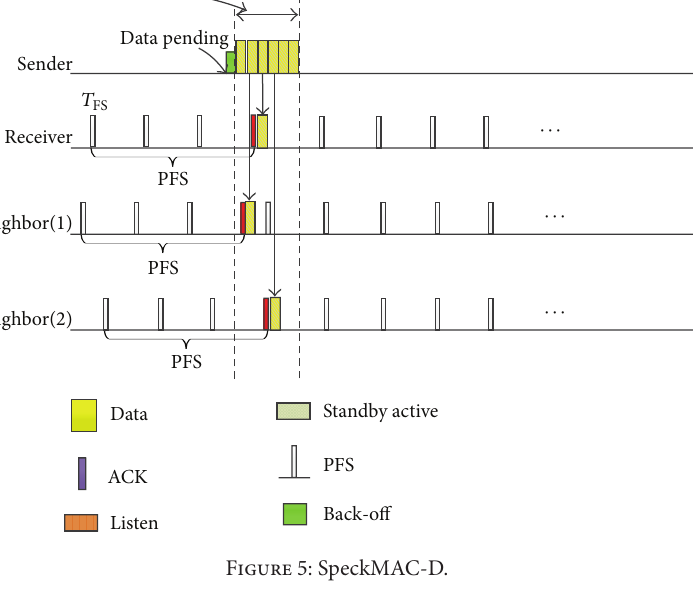
Figure 5: SpeckMAC-D.